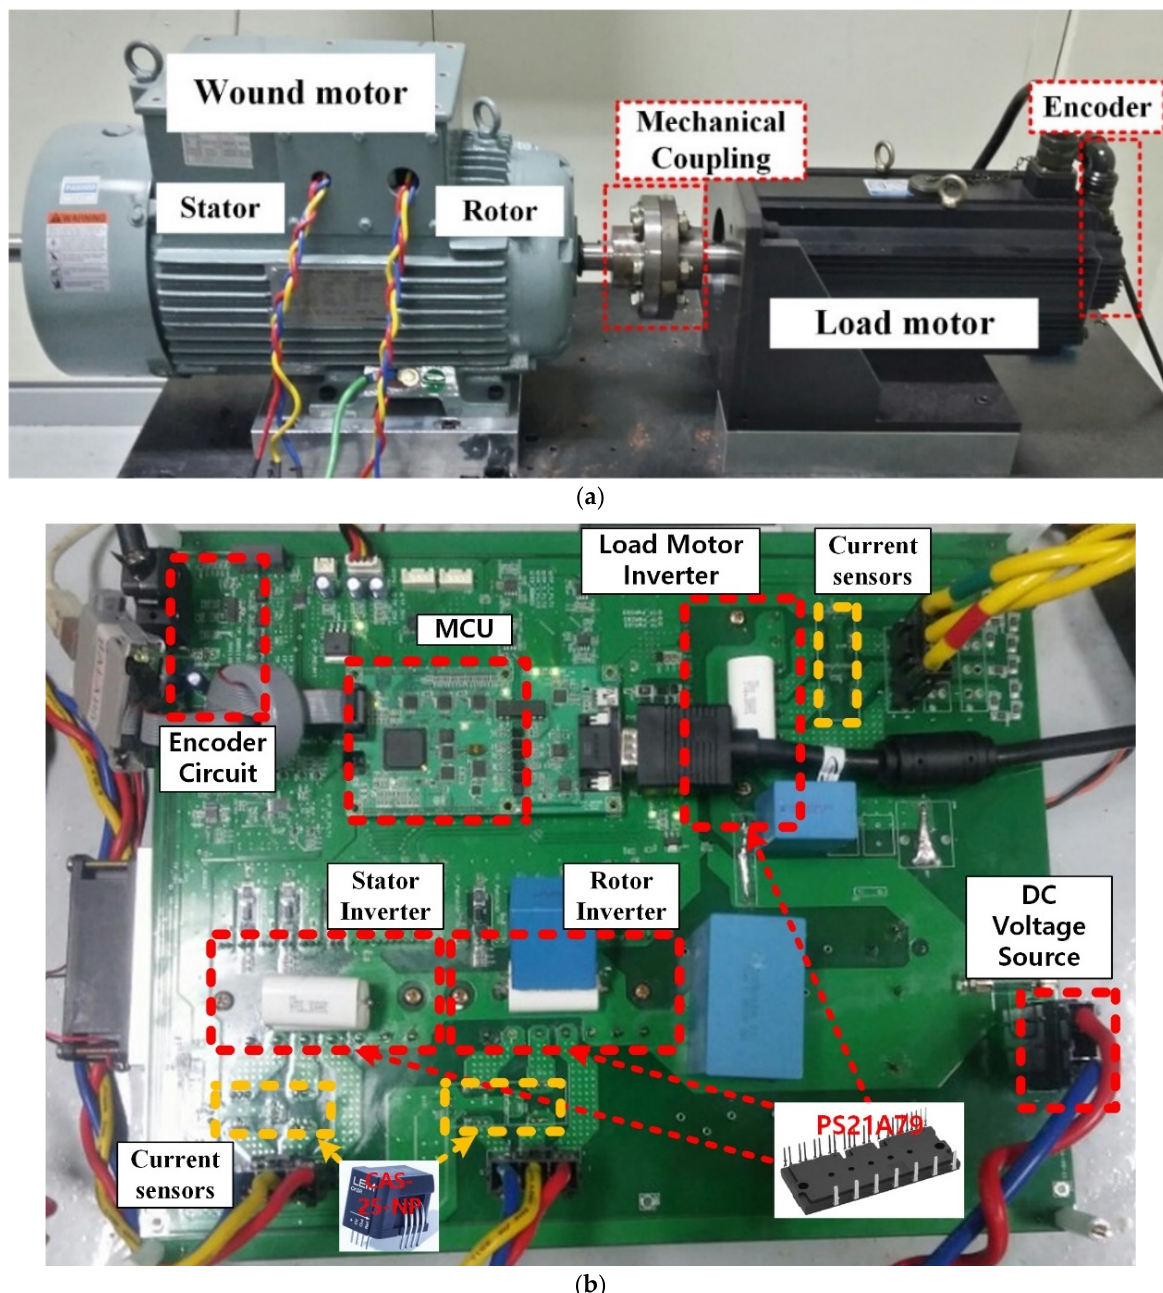
Figure 9. Test wound motor and load machine used in experiments: ( a ) Dynamo set of wound motor and load machine; ( b ) Inverter set.